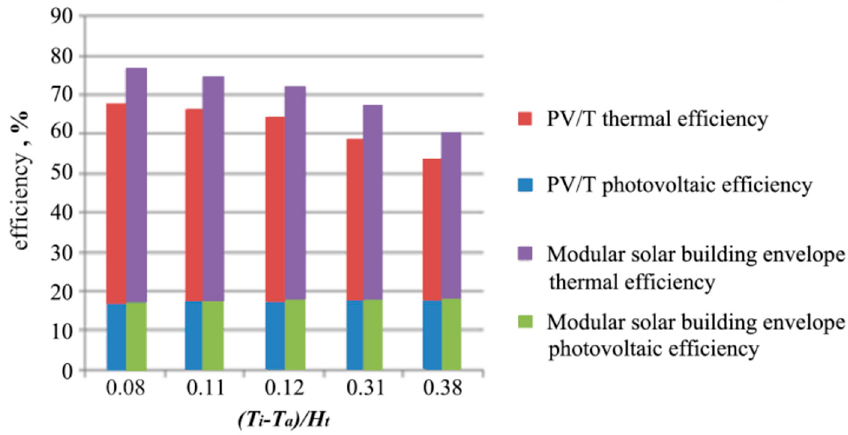
Figure 12. Efficiency comparison of module system and conventional PV/T system.